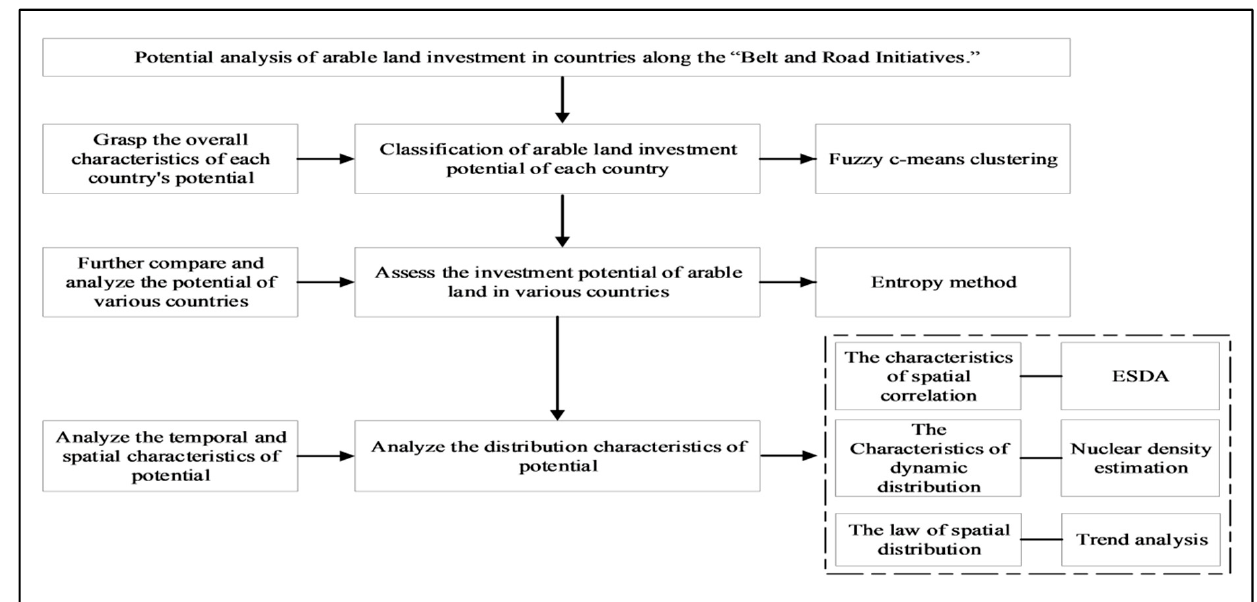
Figure 2. Workflow of the study.